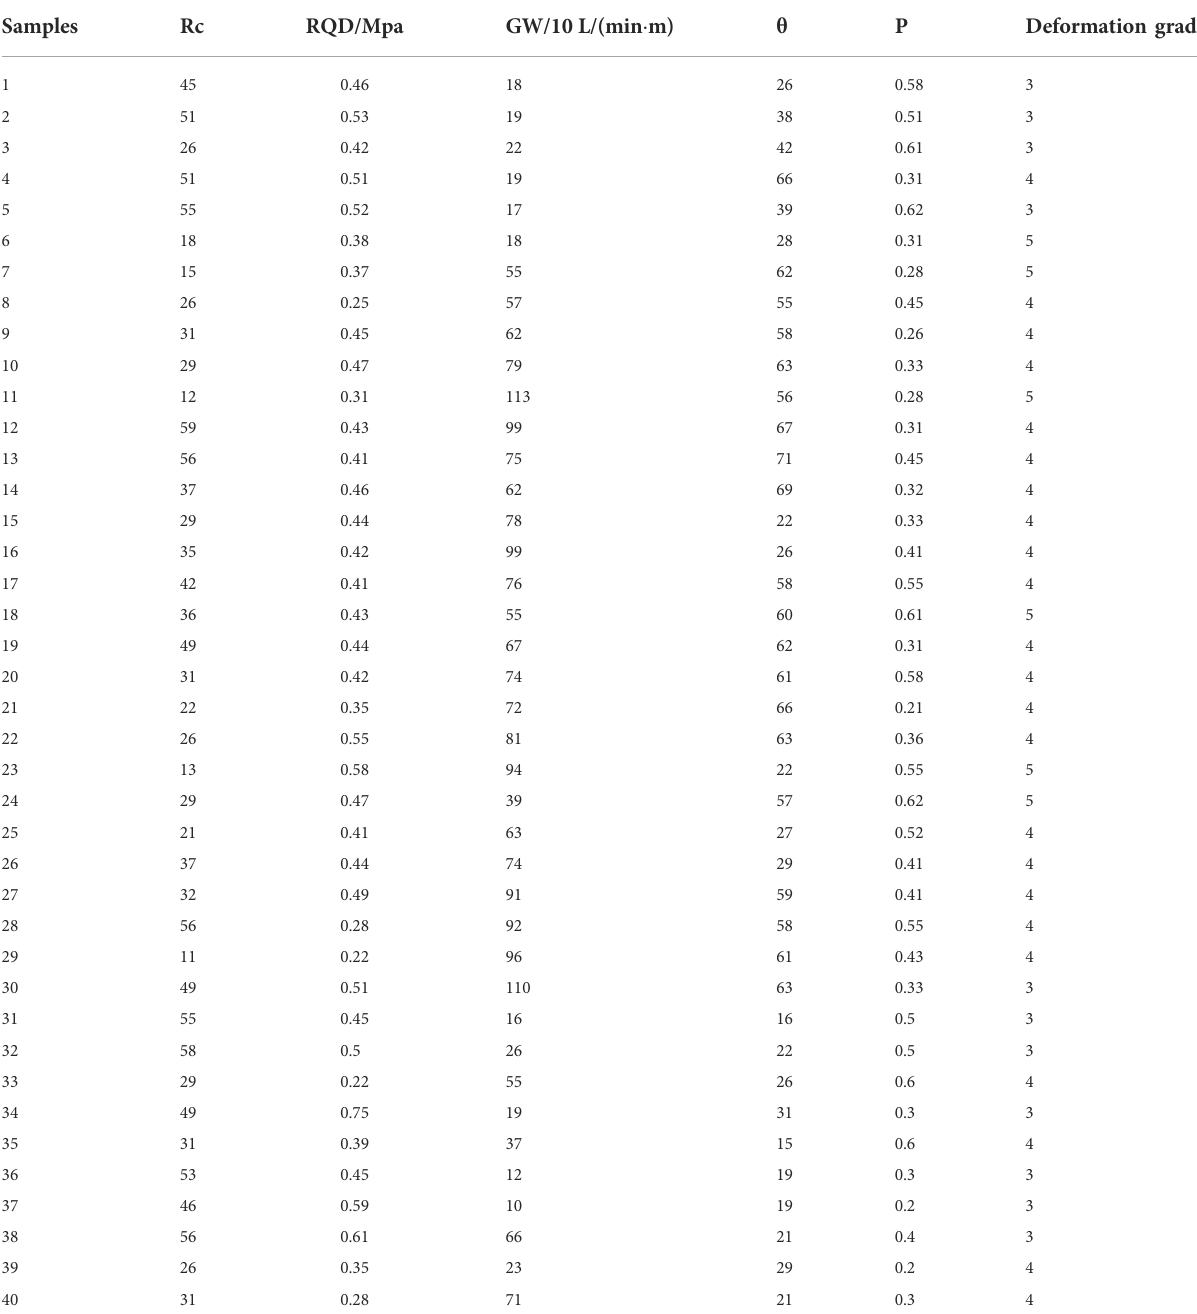
TABLE 3 Engineering cases of tunnel